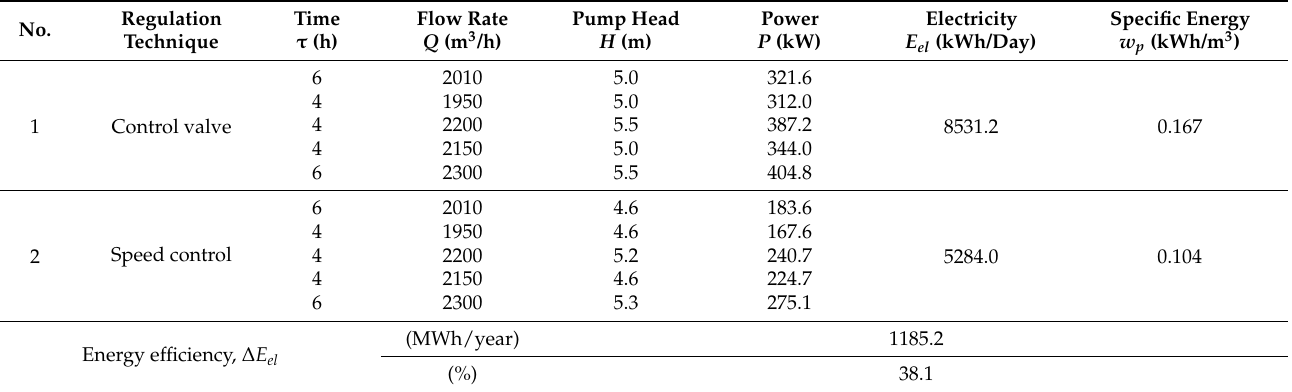
Table 9. Energy efficiency for flow control.